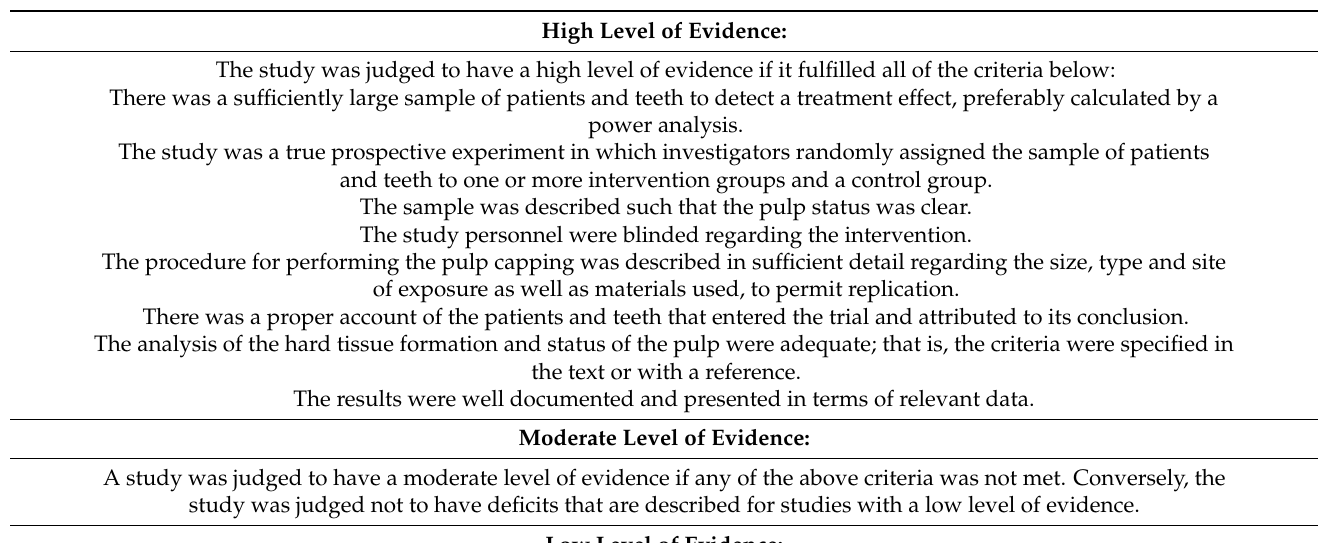
Table 5. Risk of bias according to the levels of evidence and criteria for evidence synthesis for randomized